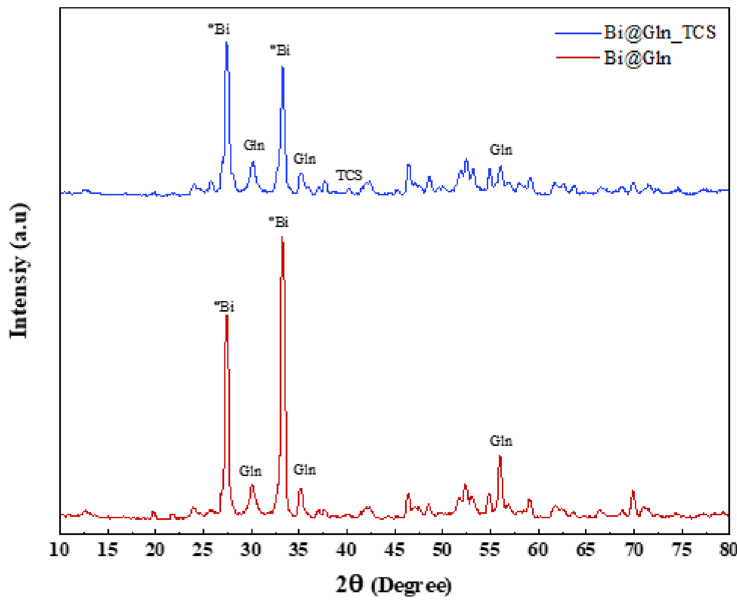
Figure 2. XRD pattern of the synthesized